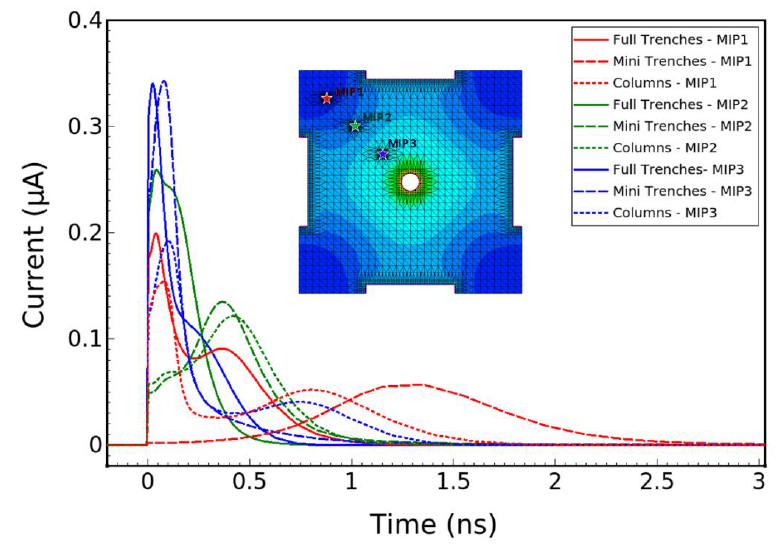
Figure 13. TCAD simulation results of the current pulse generated by an incident MIP. Current pulses are shown for MIPs incident on 3D architectures possessing full-trench (solid lines), mini-trench (large dashes), and full-column (small dashes) electrode configurations. Results are presented for MIPs incident in three various positions: MIP1 (red), MIP2 (green), and MIP3 (blue).